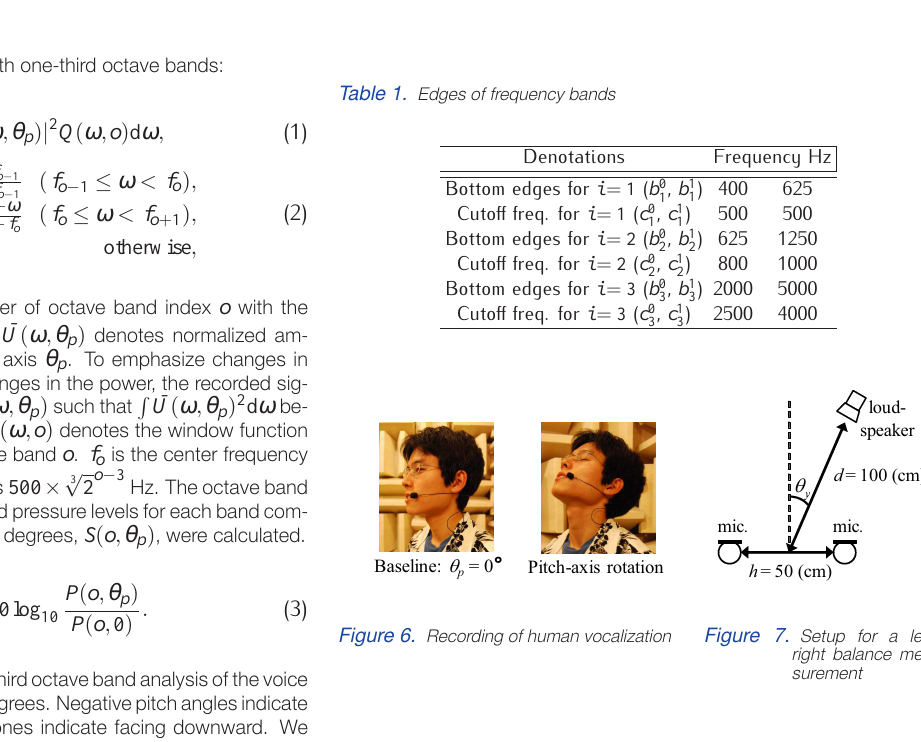
right balance mea- surement